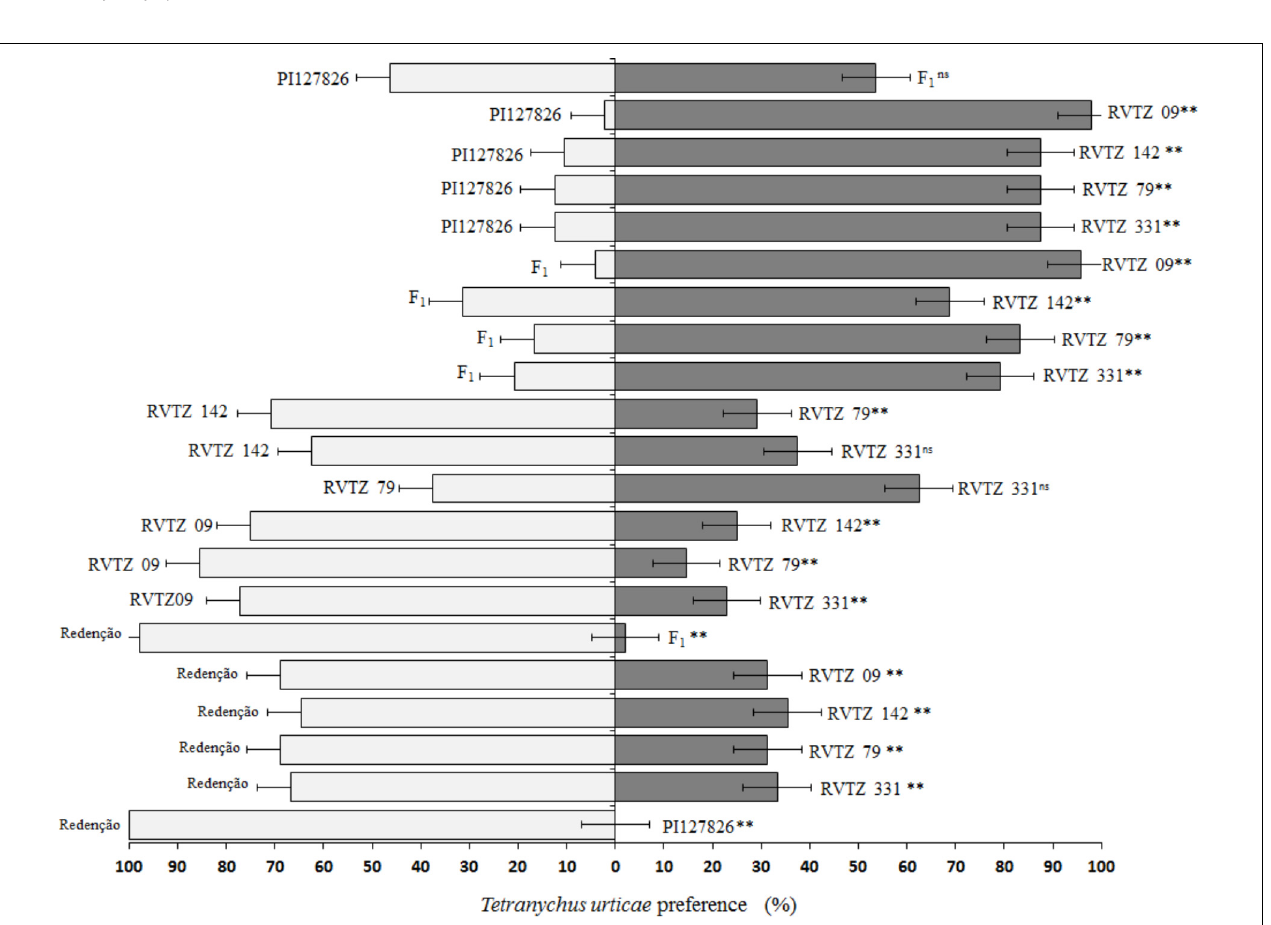
Frontiers in Plant Science |